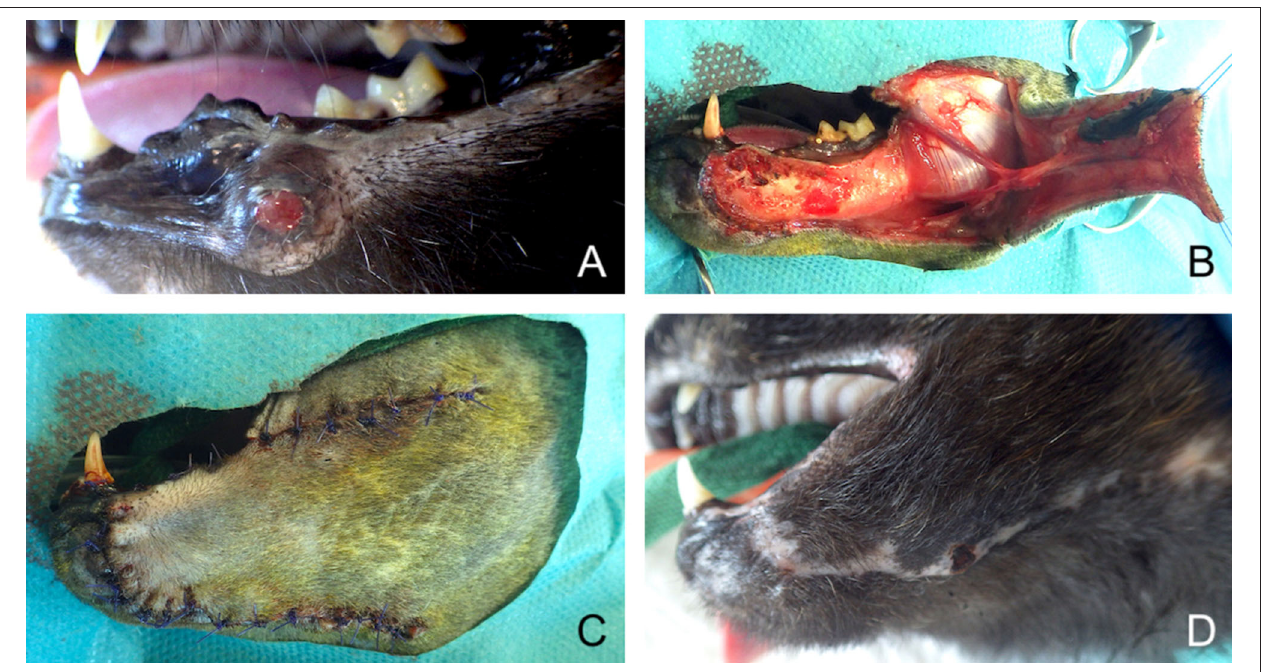
FIGURE 7 | Full-thickness local advancement flaps for closure of a defect secondary to surgical removal of a recurring lower lip trabecular adenocarcinoma. (A) Preoperative aspect of the tumour. (B) Harvesting of the flap based on facial vascularisation. (C) Immediate postoperative aspect. (D) 1-month postoperative